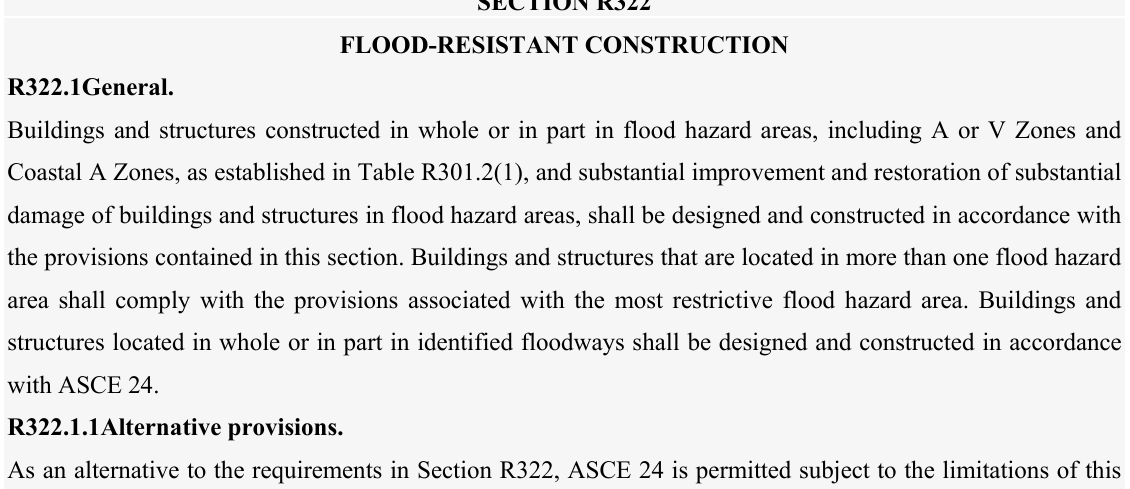
Figure 5. Part of Florida Building Code 2017 – Residential 2017 (FBC 2017-R).